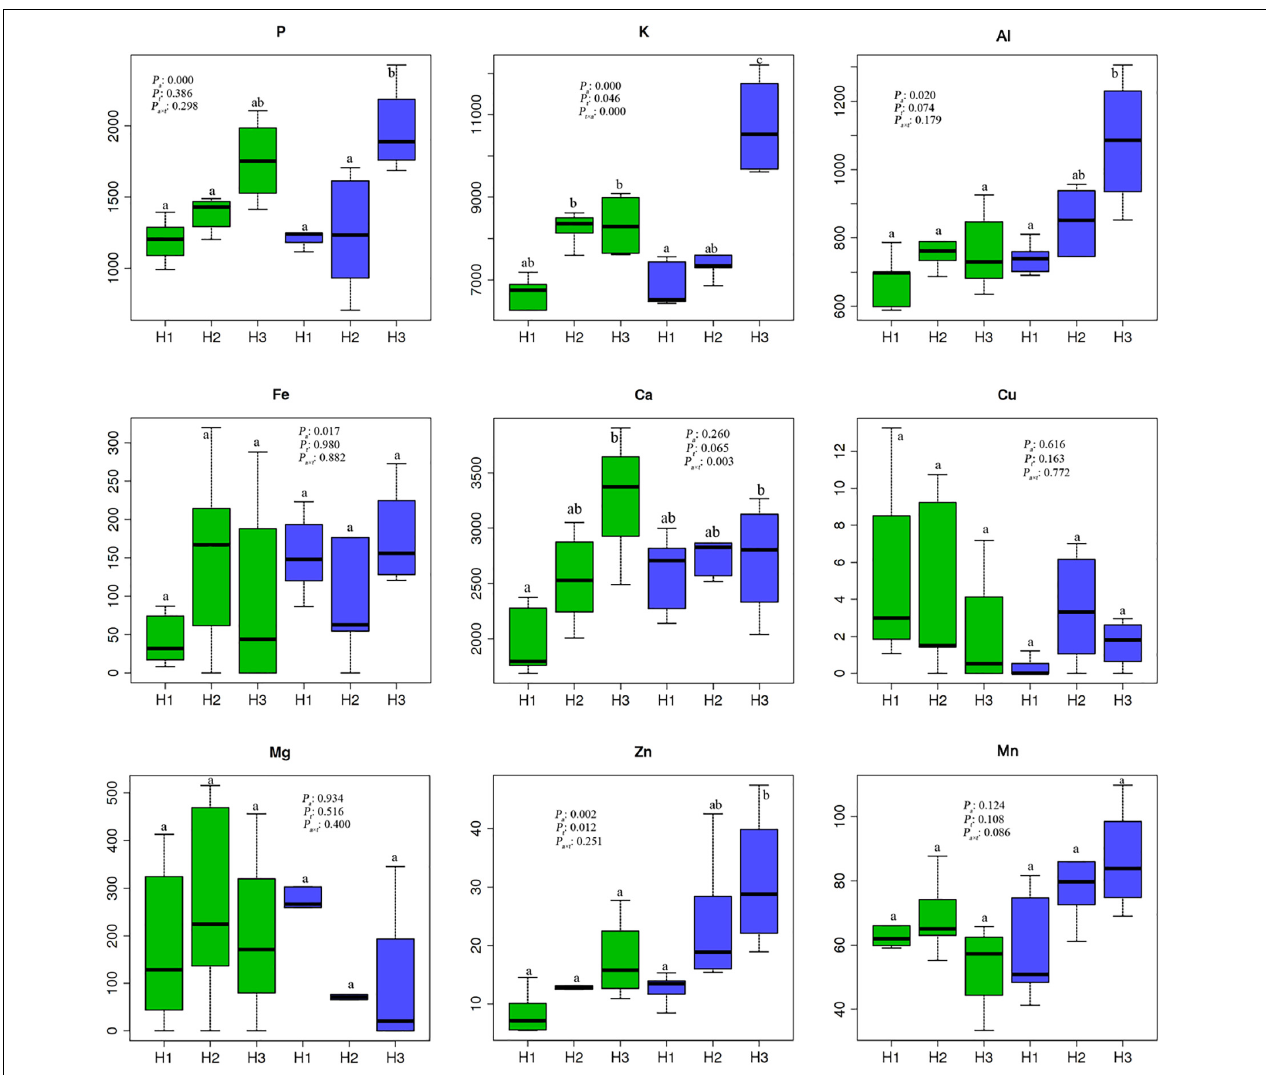
FIGURE 2 | Mineral nutrient contents ( µ g g − 1 Dw) in needles of A. faxoniana at 3,500, 3,000, and 2,600 m under controls and OTCs. Values denoted the different letters indicates a significance at p < 0.05 according to Tukey test. P a , altitude effect; P t , OTC effect; P a × t , altitude and OTC interaction effect; H1, the altitude of 3,500 m; H2, the altitude of 3,000 m; H3, the altitude of 2,600 m; the green bars indicate the control conditions; the blue bars indicate the OTC warming